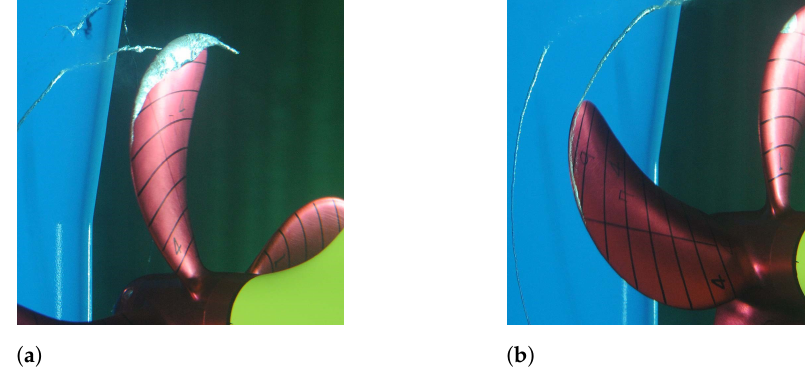
Figure 11. Normalized α at ( a ) 8 kHz and ( b ) 40 kHz (condition C 3).